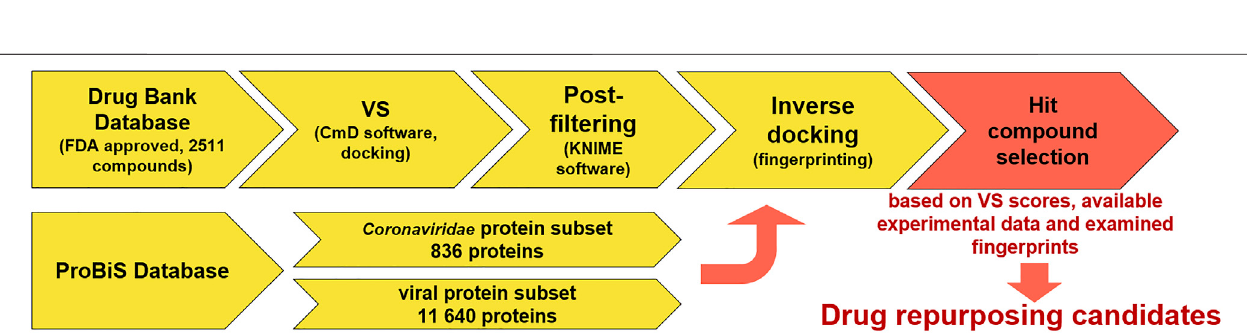
FIGURE 2 | Virtual screening coupled to inversedocking protocol for drug repurposing. The fi rst step is database selection; next is the VS campaign followed by a fi lteringstep( fi lteroffpains)witha fi nalinversedocking fi ngerprintcalculationtoexaminethetargetspacewherethecompoundsproducefavorablebindingposes(tothis end, the ProBiS database was employed to conduct two experiments in parallel — one with all viral proteins and the other with focused Coronaviridae proteins). Hit selection was performed based on VS scores and prior available experimental data (ChEMBL) along with examination of inverse docking fi ngerprints.